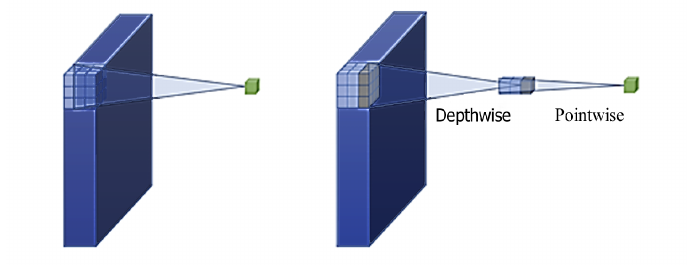
Figure 3. Traditional convolution and depth-wise separable